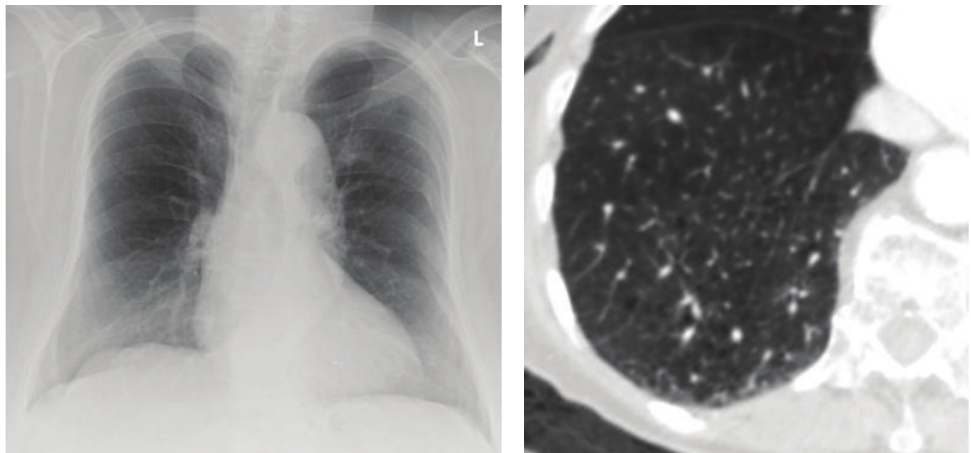
Figure 2: Senile emphysema in an 88-year-old patient. Chest X-ray (on the left) and centrilobular emphysematous changes on computed tomography (on the right). Imaging was ordered because of suspected mesenterial ischemia.